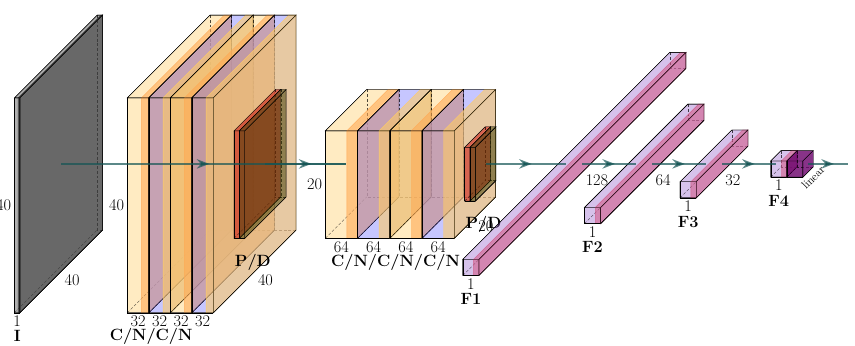
Figure 5. Deep-regression CNN architecture. I, input data; C, convolution layer; N, batch normalization layer; P, max pooling layer; D, dropout; F, fully-connected layer.